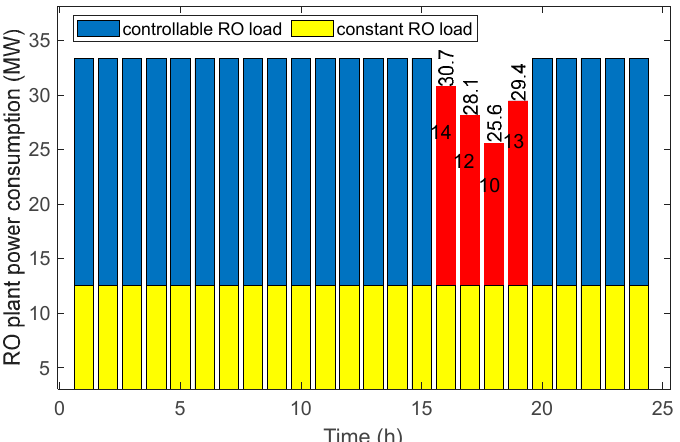
Figure 6. The hourly RO power consumption under CRRC, the number over the bars are the power consumption in MW and that inside the bars are the number of ON trains at each hour.